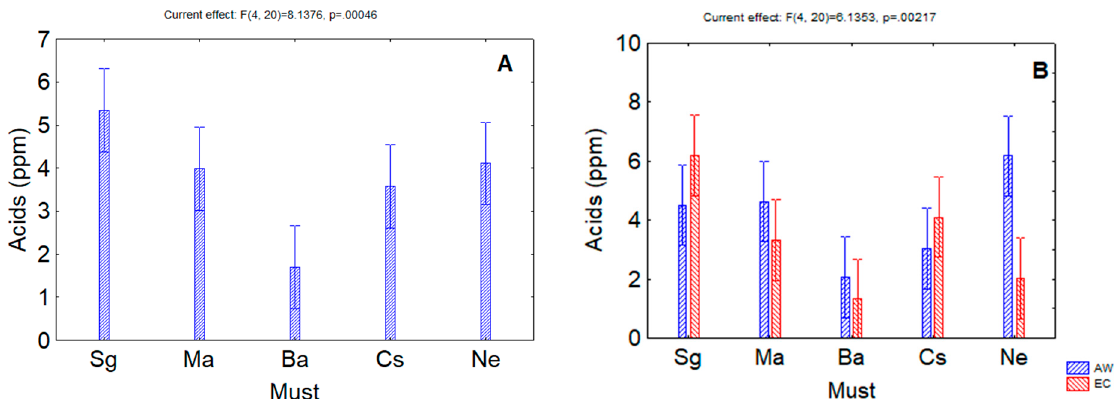
Figure 4. Decomposition of the statistical hypothesis for the effects of must ( A ), and interaction must × strain ( B ) on the total amounts of acids. Bars denote 95%-confidence intervals. Sg, Sangiovese; Ma, Magliocco; Ba, Barbera; Cs, Cabernet-Sauvignon; Ne, Negroamaro. EC, strain EC1118; AW, strain AWRI796. Table 2. Significance ( p -level) of the categorical predictors and their interaction on the amounts of some selected esters and alcohols produced by S. cerevisiae AWRI796 and EC1118 throughout the fermentation of five red grape musts; ns, not significant ( p >